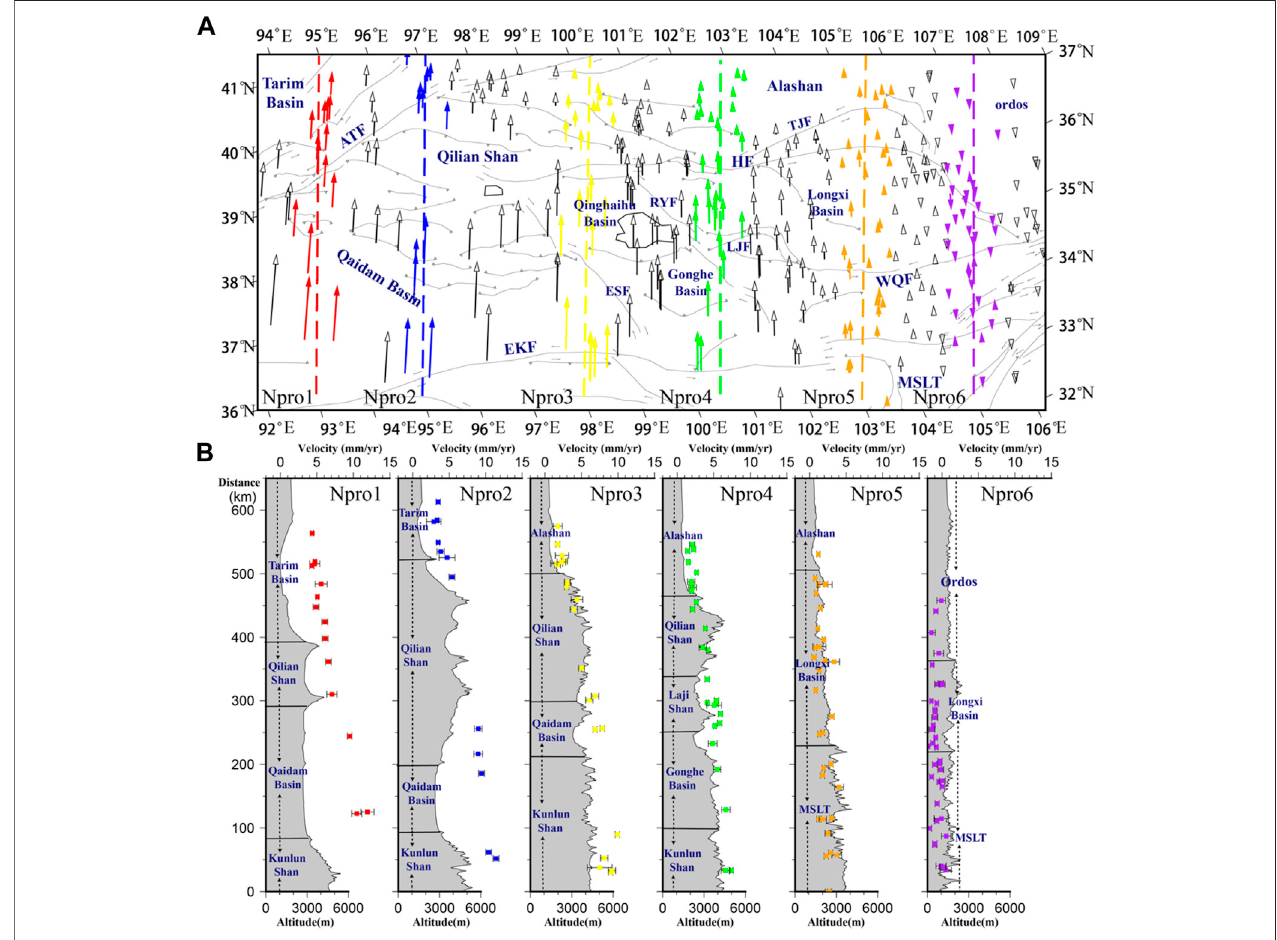
FIGURE4|(A) LocationofsixGPSvelocitypro fi lesinQFTB. (B) Pro fi leNPro1 – 6ofGPSvelocityperpendiculartothetrendoftheQFTBwith1errorbar.Thecolors represent the different velocity pro fi les and their available GPS